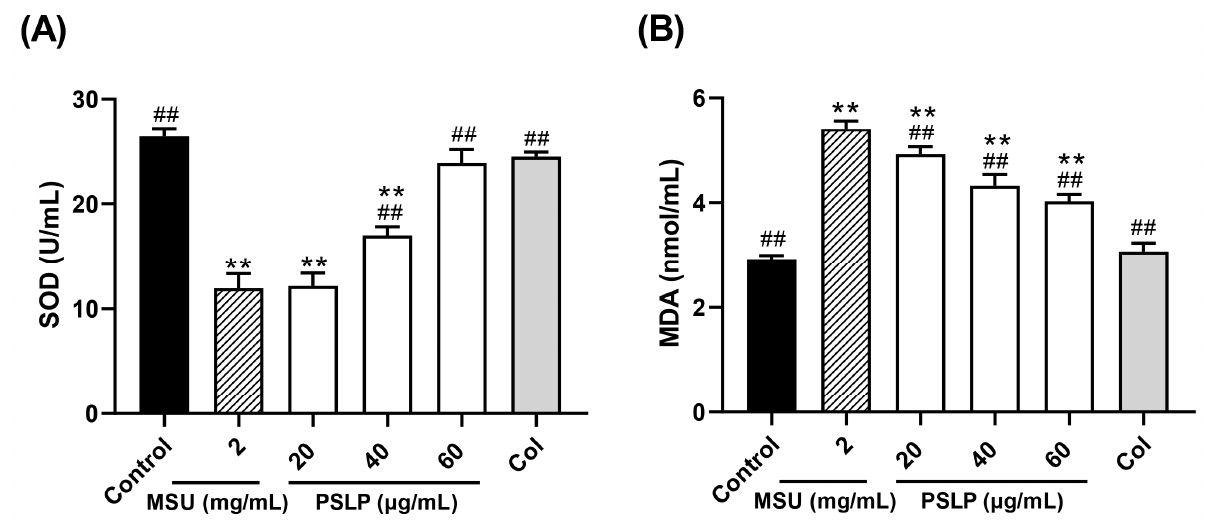
Figure 5. Effect of PSLP on intracellular SOD ( A ) and MDA ( B ) levels in MSU-stimulated RAW264.7 cells. The values were expressed as means ± SD ( n = 3), ** p < 0.01 vs. the control group. ## p < 0.01 vs. the MSU group.